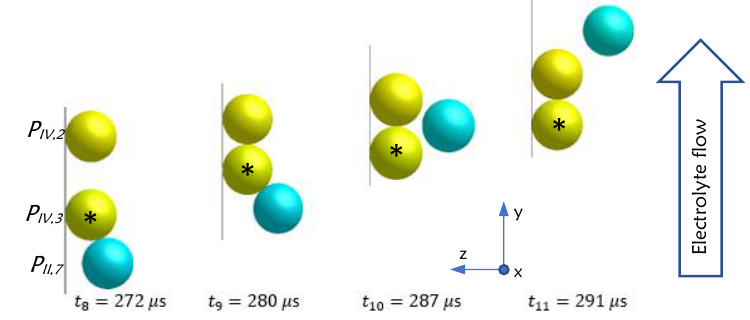
Figure 18 Enlarged view of Figure 17. A “*” is marked on particle P IV,3 for identification